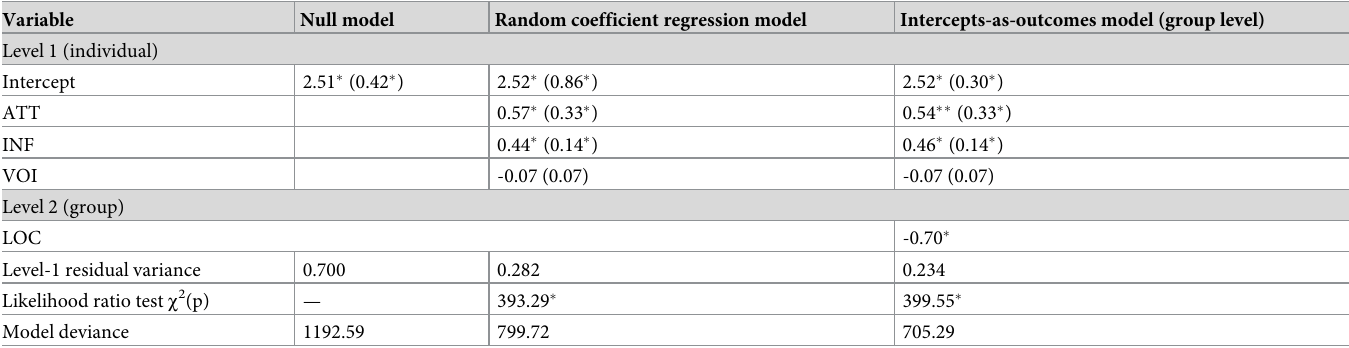
Table 6. Results of hierarchical linear modelling for